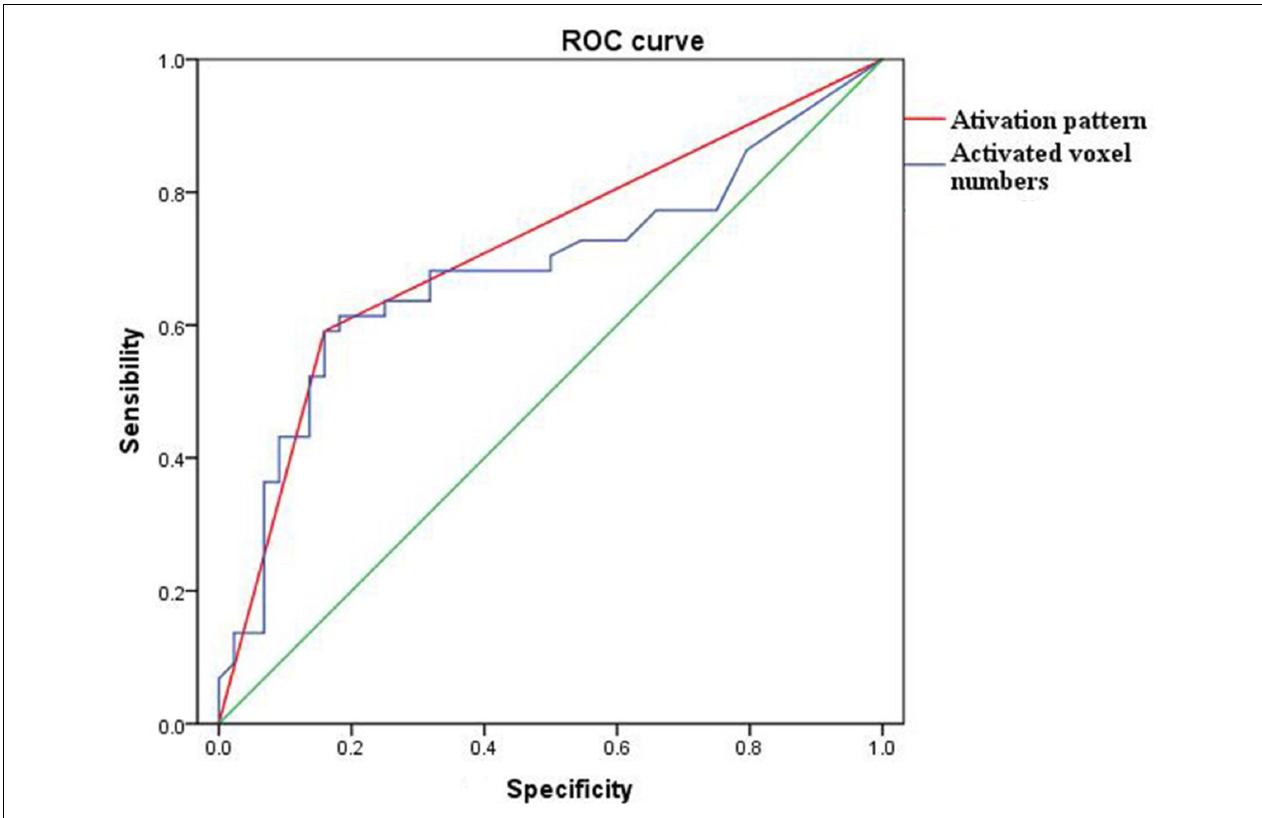
FIGURE 6 | The ROC curve of activation pattern (red) and activated voxel numbers (blue) of POC to differentiate the AD cases and NC subjects. The areas under curve of activation pattern and activated voxel numbers were 0.685 and 0.716,